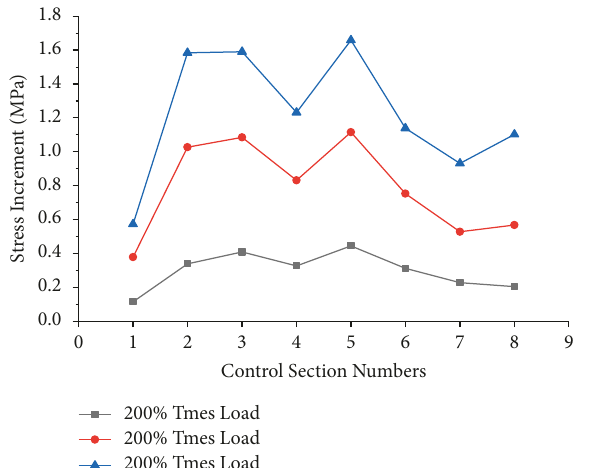
Figure 10: Stress changes in the main tower under 200% ∼ 400% times